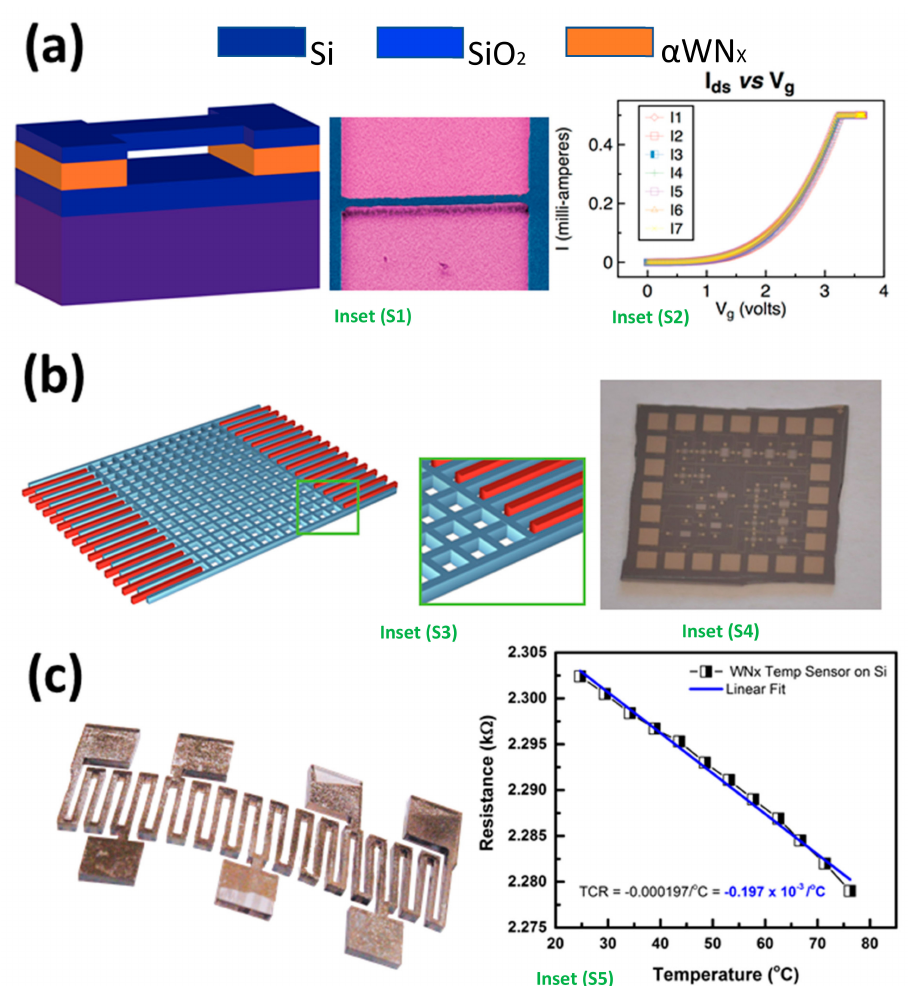
Figure 2. WN x –based devices. ( a ) Schematic of nano-scale NEM switch design layout, the correspond- ing SEM image (Inset S1), and the I–V characteristics plot (Inset S2); ( b ) micro-scale accelerometer design layout (rivet snippet shown in Inset S3) and optical image of the fabricated device (Inset S4); ( c ) a macro-scale resistive temperature sensor design layout, with the corresponding sensitivity plot (Inset